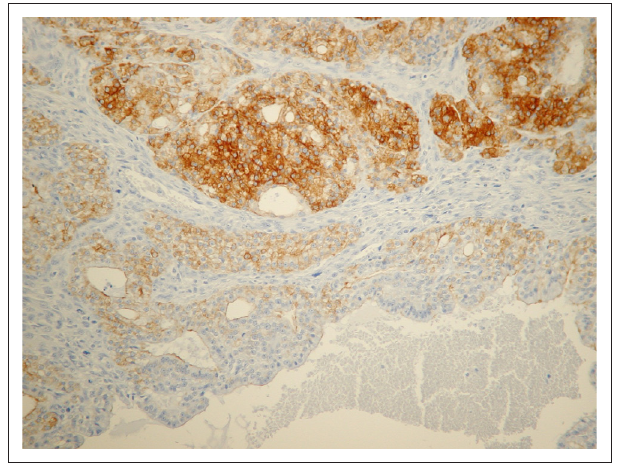
Magnification: 2×. FIGURE 4: Micrograph of the thyroid carcino-sarcoma stained with cytokeratin, showing lobes of epithelial tubules and